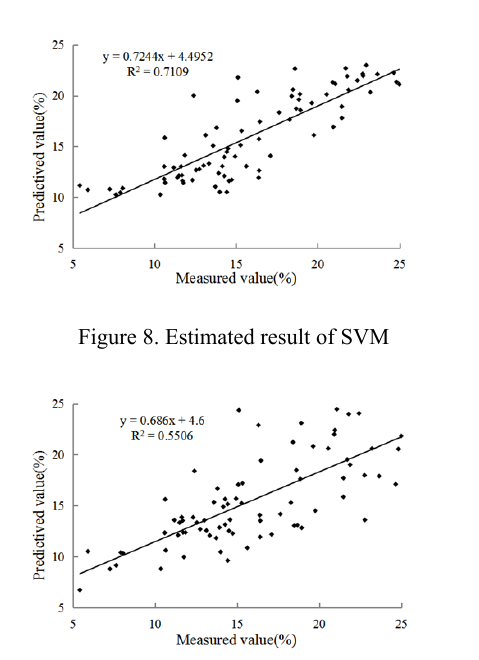
Figure 7. Estimated result of BP-NN